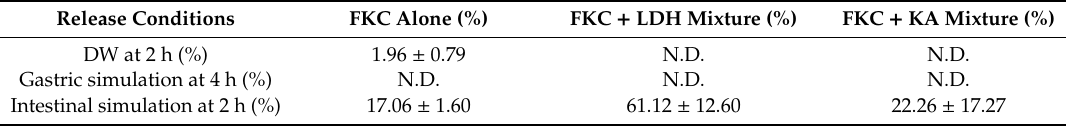
Table 3. Cumulative FKC release from alginate beads at various